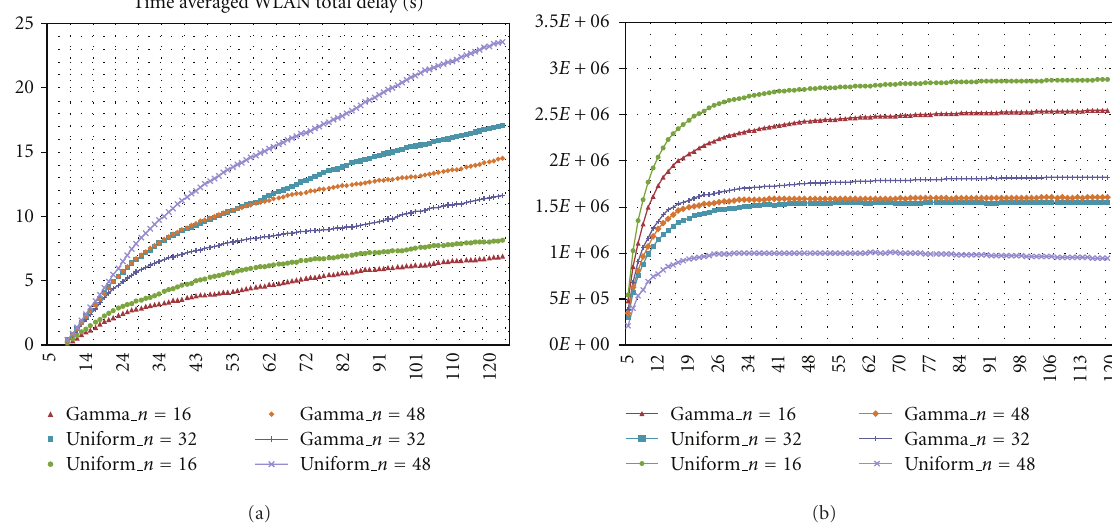
Figure 6: As illustrated, each bundle includes two simulations: one Gamma curve and one PDF curve. (right): Total network throughput comparison between Gamma and Uniform PDFs. Gamma PDF outperforms Uniform one especially for higher number of contending stations. (left): Total service delay comparison. In all scenarios, lower total delay achieves when applying Gamma instead.